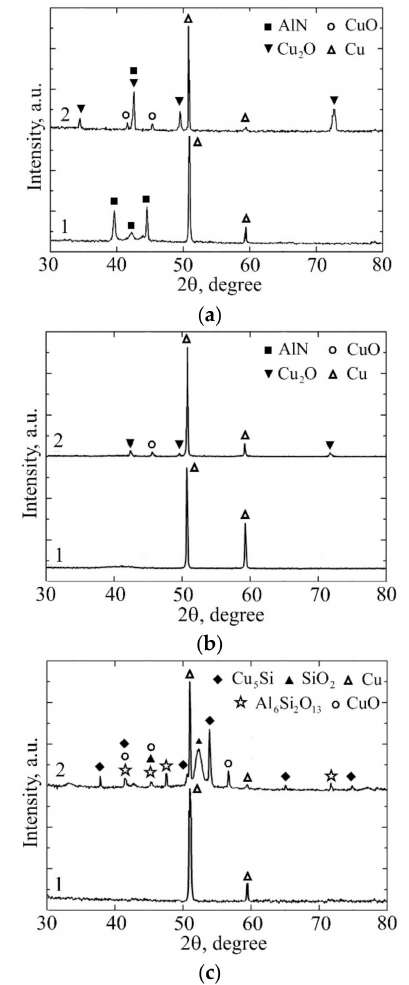
Figure 1. XRD patterns of Al 0.88 Si 0.12 N ( a ), Al 0.74 Si 0.26 N ( b ) and Al 0.11 Si 0.89 N ( c ) coatings. The curves labeled as (1) correspond to the as-deposited coatings, while those designated as (2) belong to the coatings subjected to 25 ( a ) and 1 ( b , c ) thermal